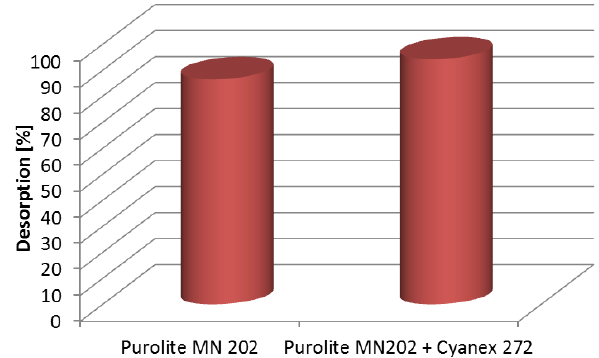
Figure 10. Desorption of gold(III) ions using 5% thiourea in a 0.1 M HCl solution.